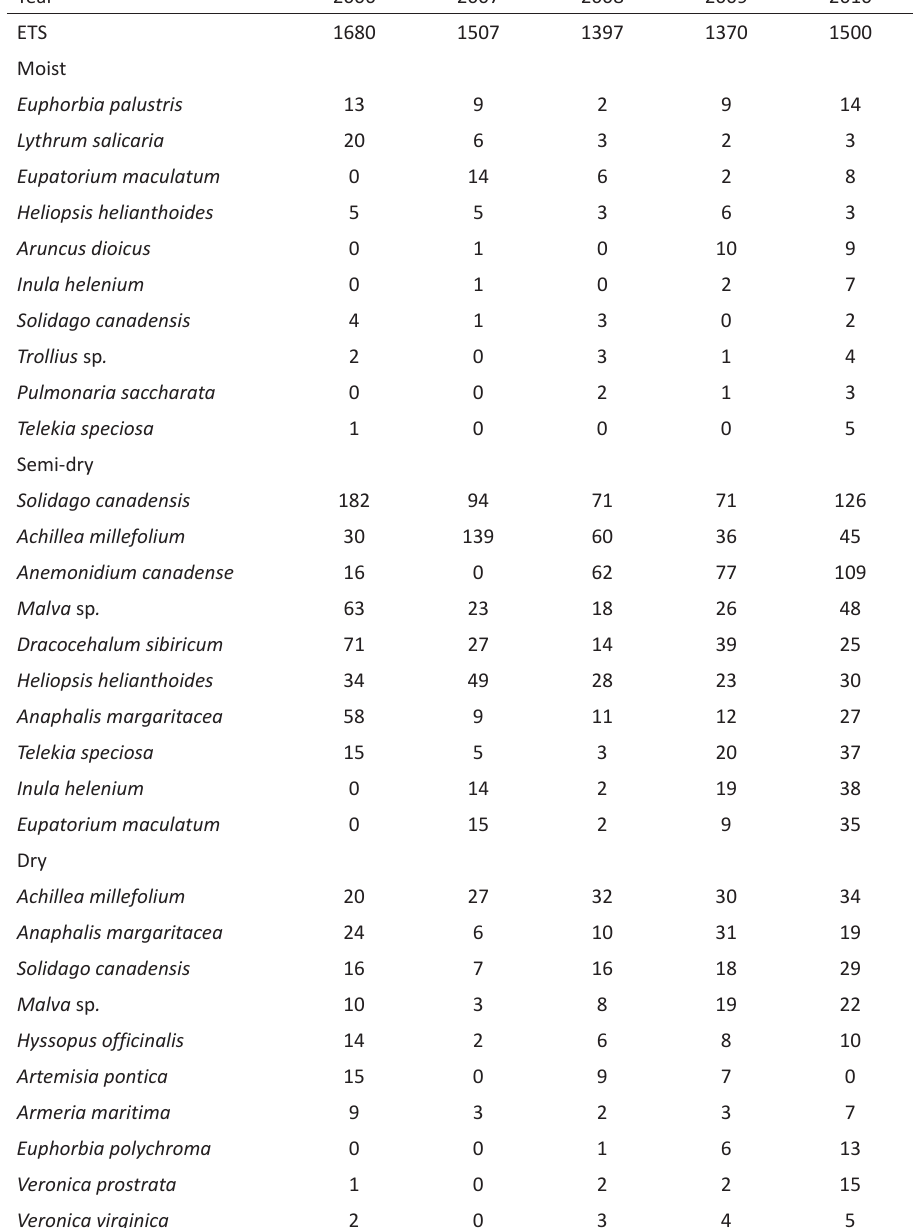
Table 5. Number of observed seedlings for ten species that produced highest number of seedling in moist, semi-dry and dry blocks in the moisture controlled field experiment. Species are sorted by sum of seedlings over years 2006 to 2010. None of the species differed in post-hoc pair-wise